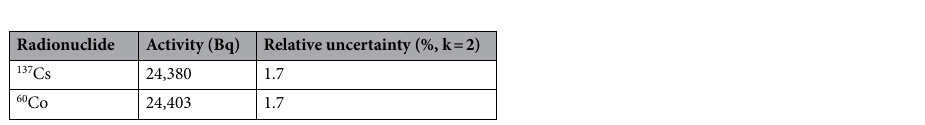
Table 8. Radioactivity of standard point sources.